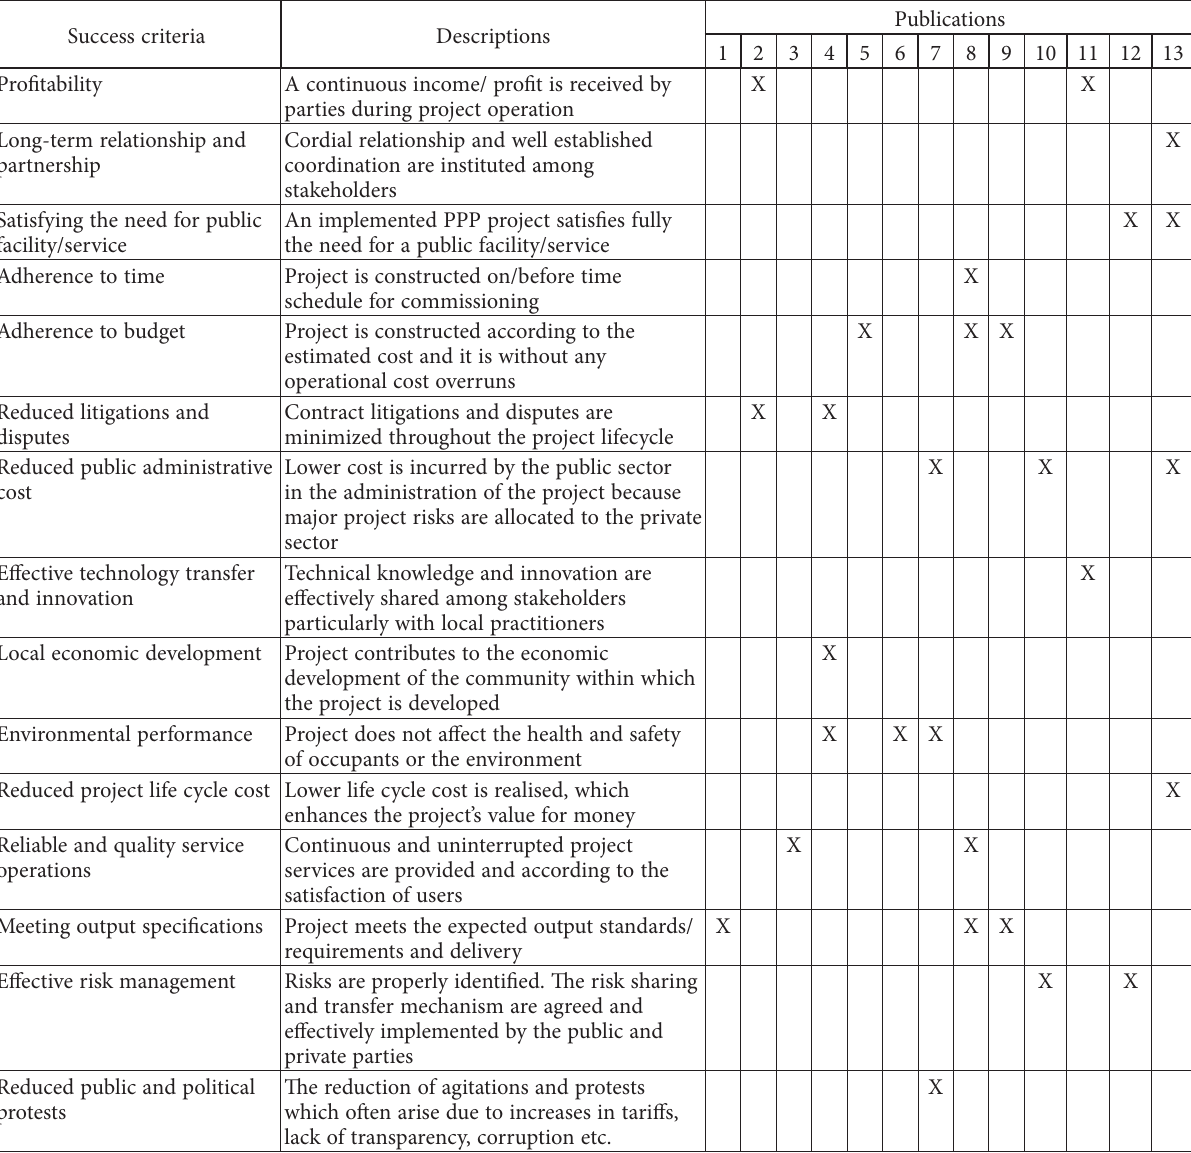
Table 1. PPP projects success criteria (Osei-Kyei et al.,